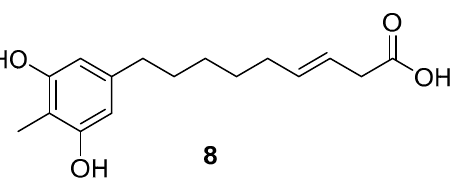
Figure 2. 9-(3,5-dihydroxy-4-methylphenyl)nona-3( Z )-enoic acid 8 from H. sericeae [30,31].